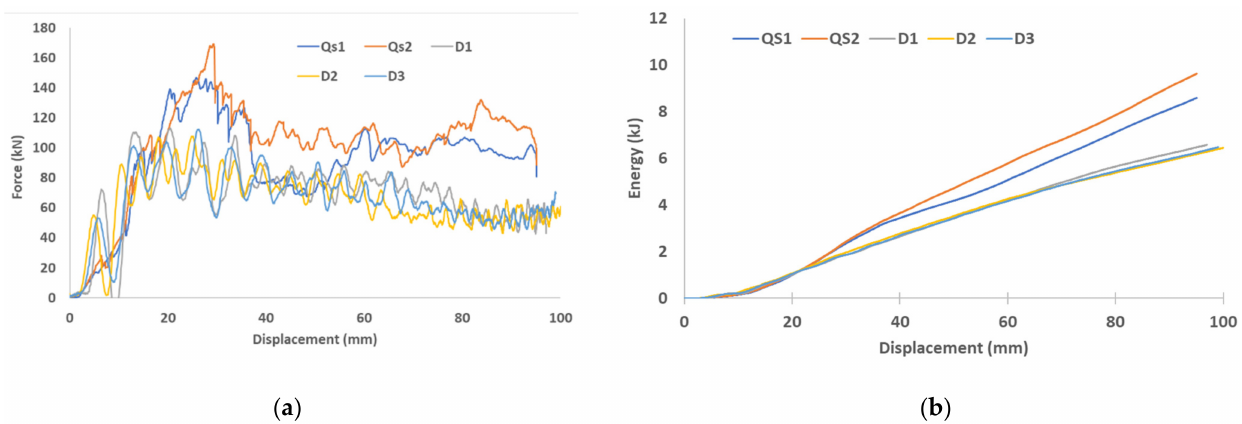
Figure 12. ( a ) Force-displacement curves of dynamic and quasi-static axial crush ( b ) Energy-displacement curve of dynamic and quasi-static axial